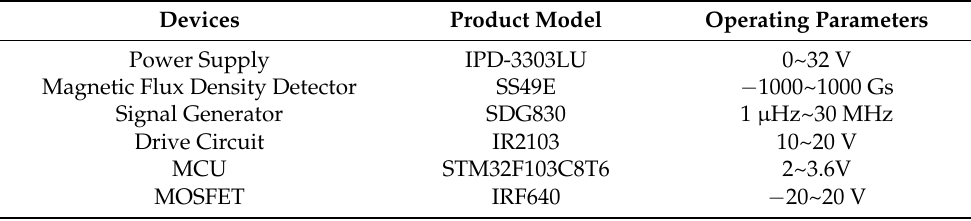
Table A1. General specifications of measuring devices used in the WPT experiment.